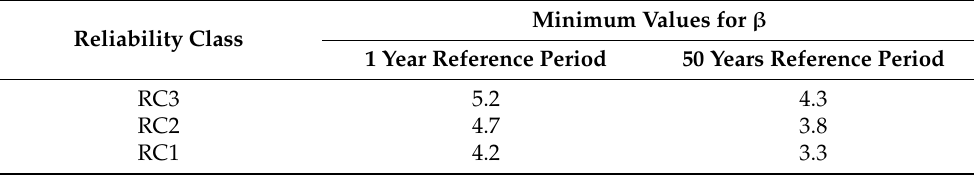
Table 2. Recommended minimum values for reliability index in the case of ultimate limit state [49].